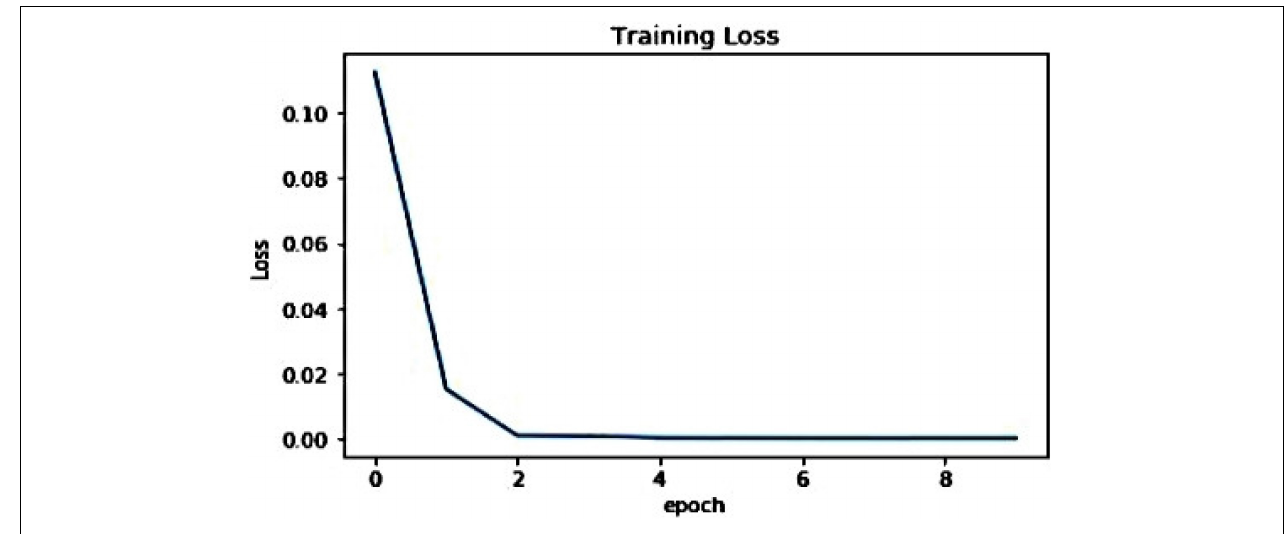
FIGURE 5 | Visual representation of training loss